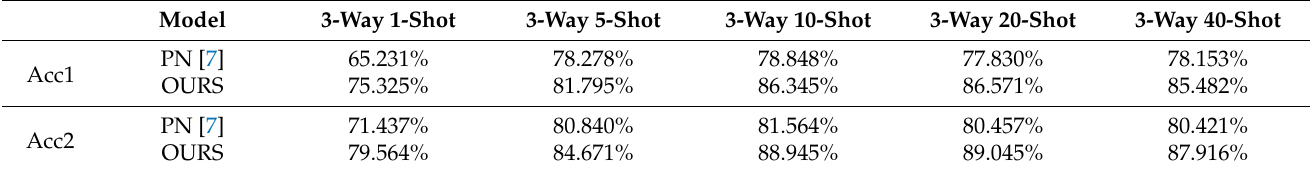
Table 8. Classification accuracy on open-set few-shot recognition with different support set